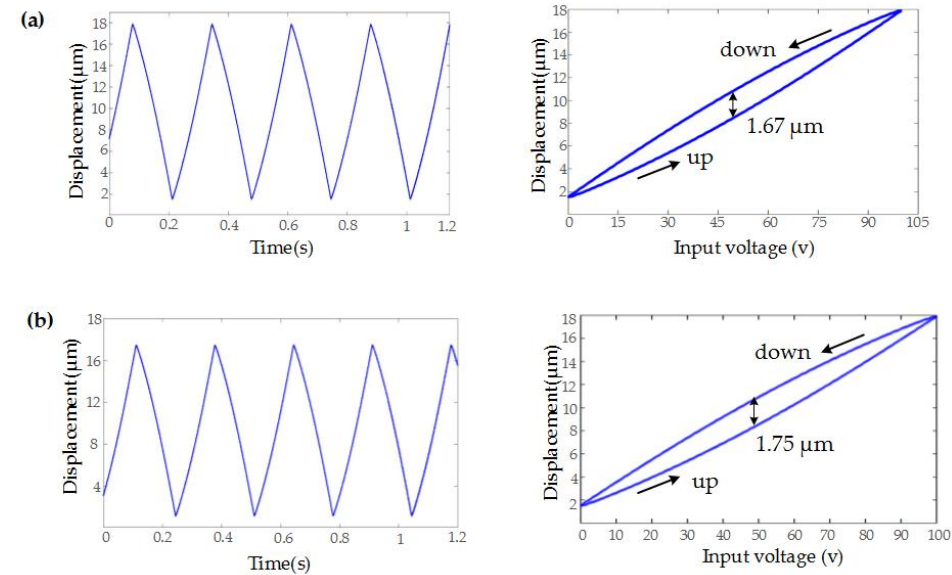
Figure 20. Hysteresis characteristic curve: ( a ) z-axis direction; ( b ) x-axis direction.